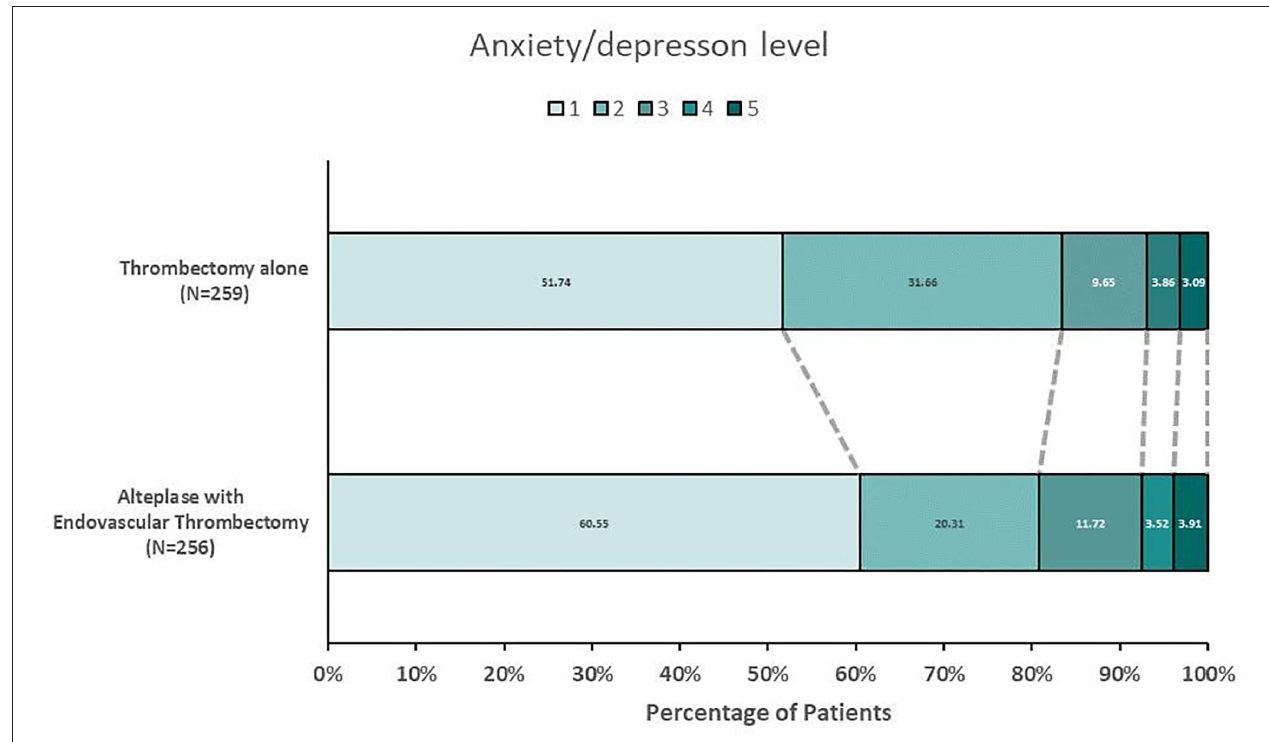
FIGURE 2 | Distribution of patient-reported anxiety/depression in EQ-5D-5L in the Intention-to Treat Population. Shown are levels on the patient-reported anxiety/depression for the patients in the two treatment groups who returned EQ-5D-5L. Levels range from 1 to 5, with 1 indicating no anxiety/depression, 2 minor anxiety/depression, 3 moderate anxiety/depression, 4 severe anxiety/depression, and 5 extremely severe anxiety/depression. The incidence of patient-reported anxiety/depression (level 2,3,4,5) in Thrombectomy alone group was significantly higher than that in combination-therapy group (48.26% vs. 39.45%, P =